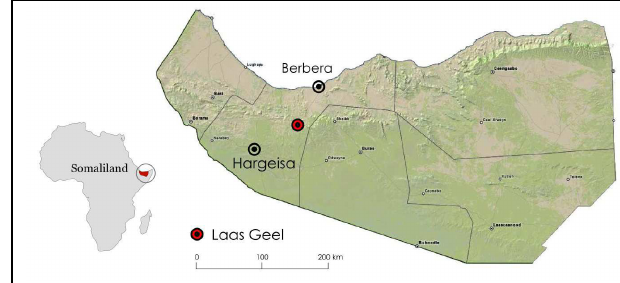
Fig.1 Situation of Laas Geel (Source : OpenStreetMap